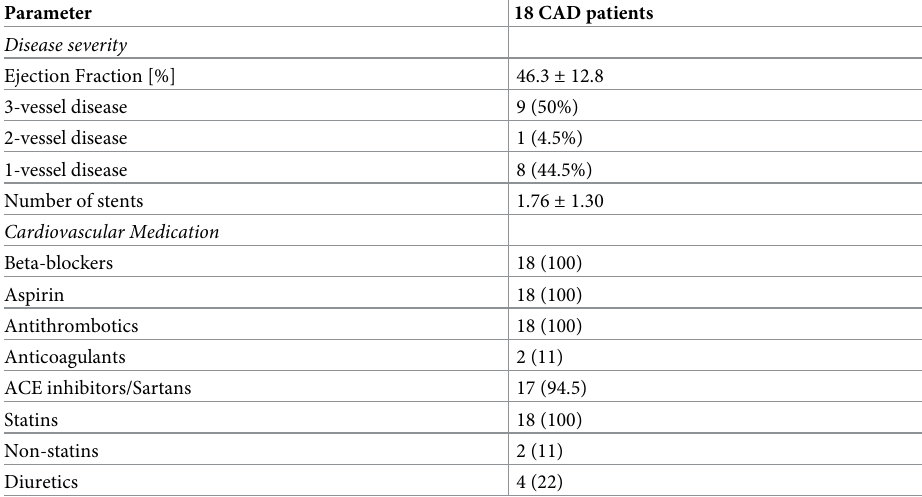
Table 2. Baseline Characteristics and medication of the CAD group.